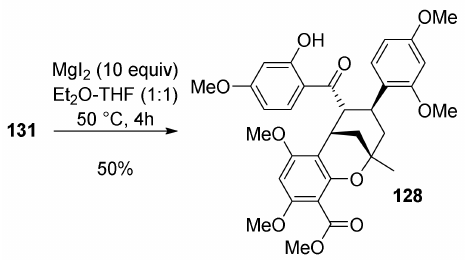
Figure 43. Synthesis of ( ± )-morusalbanol A pentamethyl ether ( 128 ).